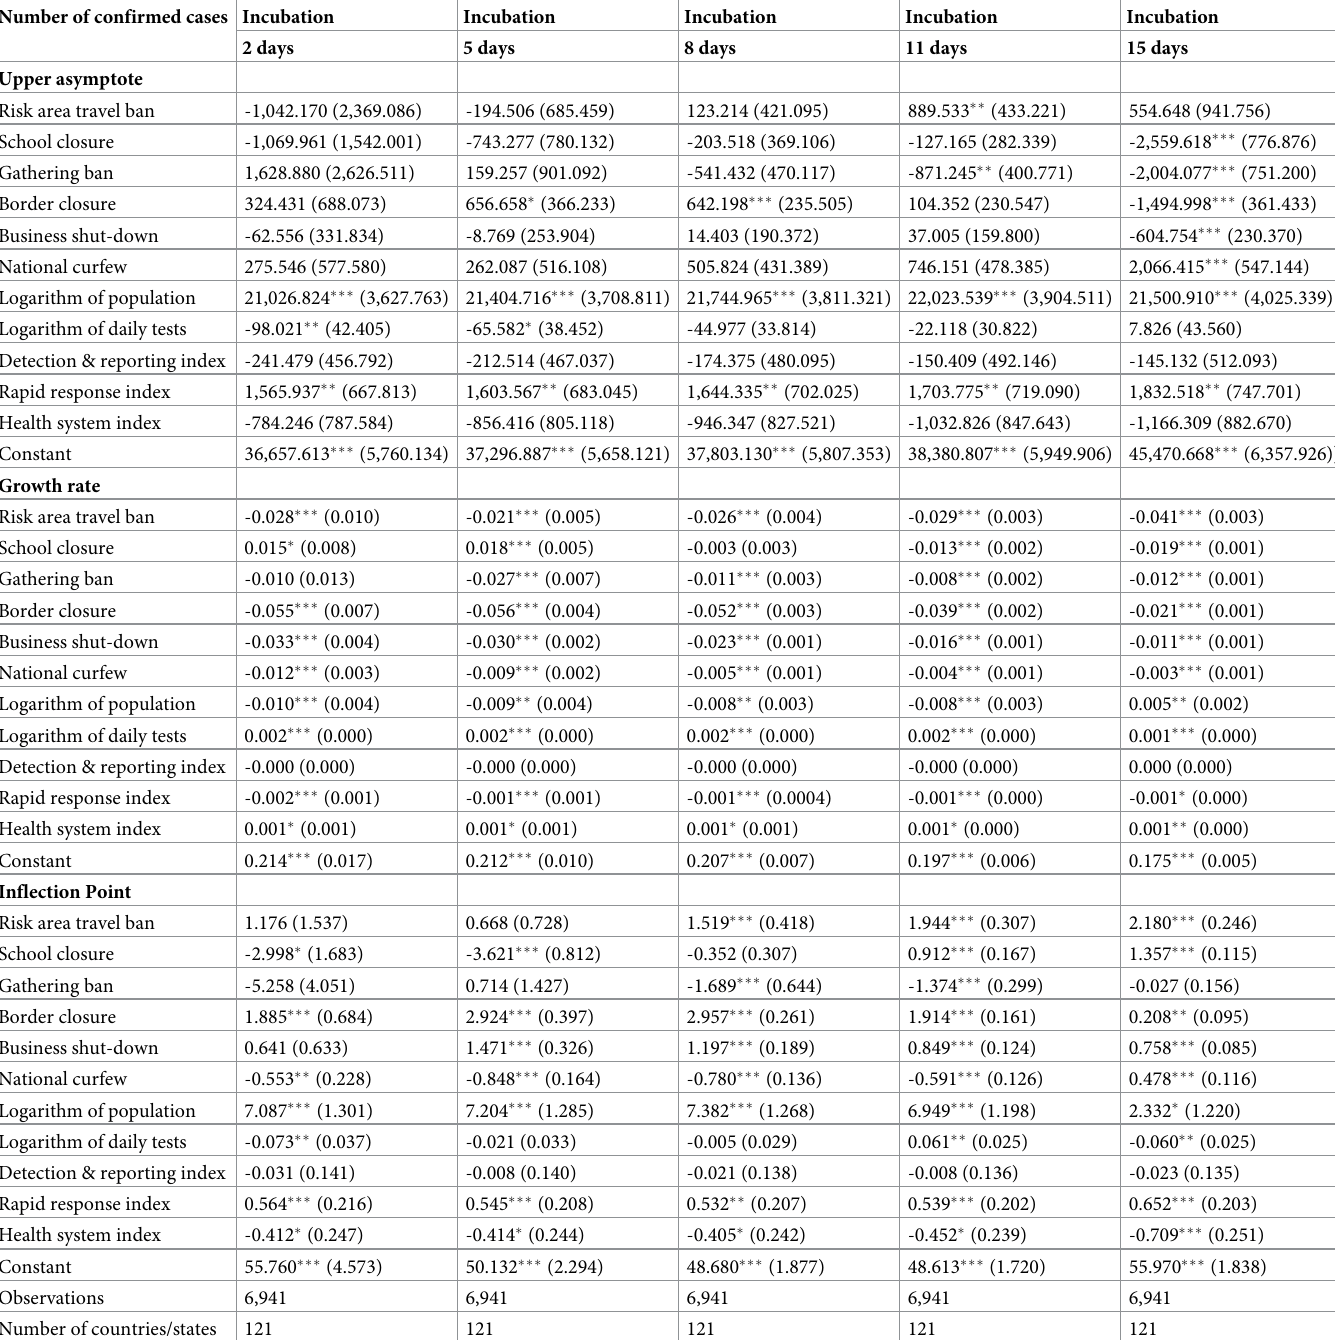
Table 3. Nonlinear mixed-effect regression results of the individual